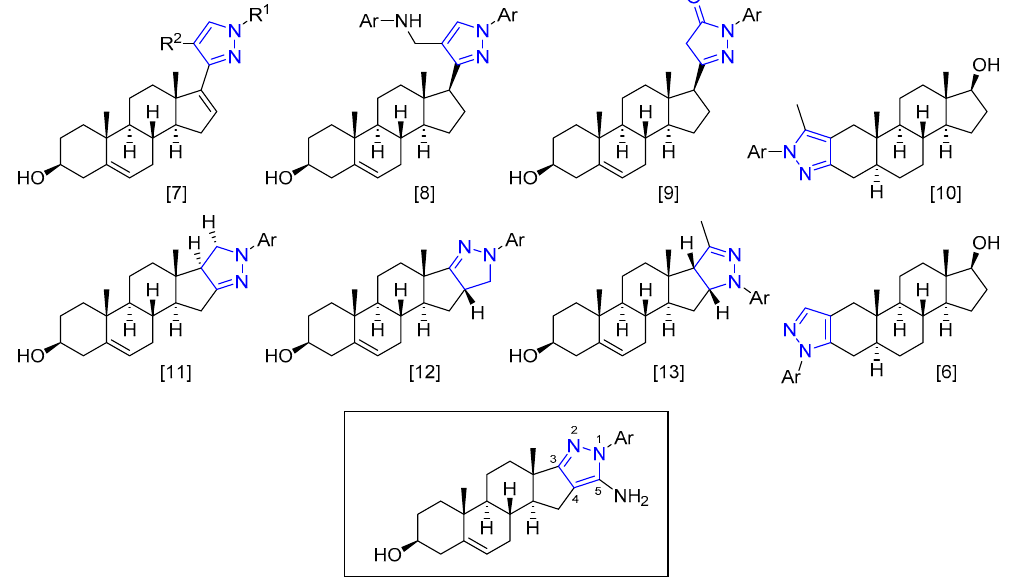
Figure 1. Some previously synthesized androstane-based pyrazol(in)es with anticancer activity [6  13] and 5-amino-1-arylpyrazoles (framed), which are the subjects of the present